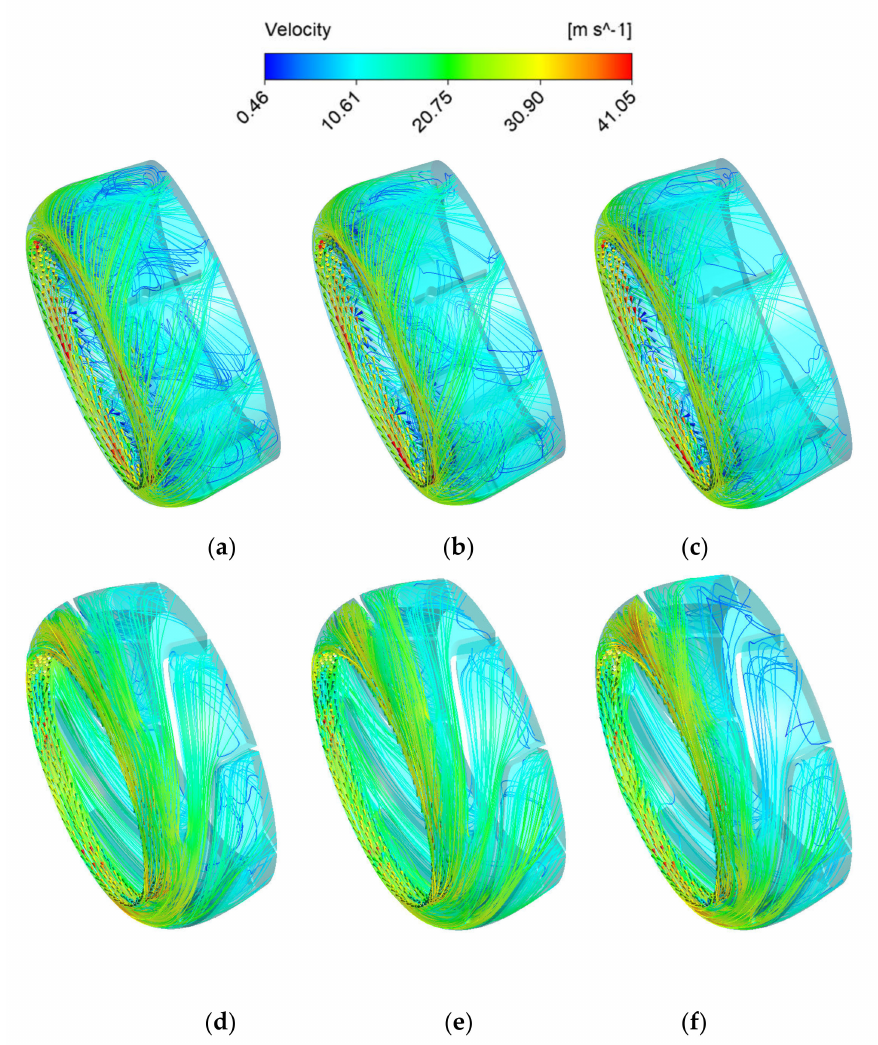
Figure 13. Comparison of guide vane velocity streamlines. ( a ) 0.8 Q d of the initial pump, ( b ) 1.0 Q d of the initial pump, ( c ) 1.2 Q d of the initial pump, ( d ) 0.8 Q d of the optimized pump, ( e ) 1.0 Q d of the optimized pump, and ( f ) 1.2 Q d of the optimized